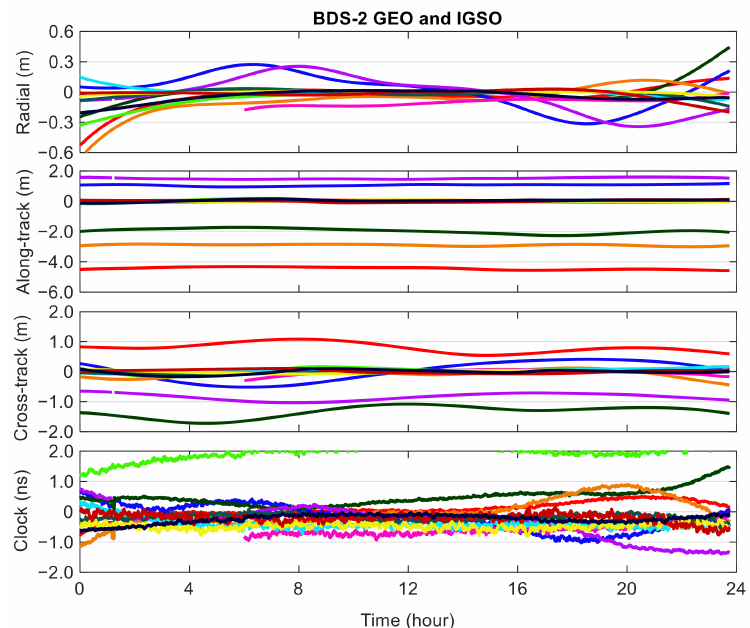
Figure 6. Epoch-wise orbit and clock differences for BDS-2 GEO and IGSO satellites between GFZ and WHU precise products on DOY 122 of 2020.